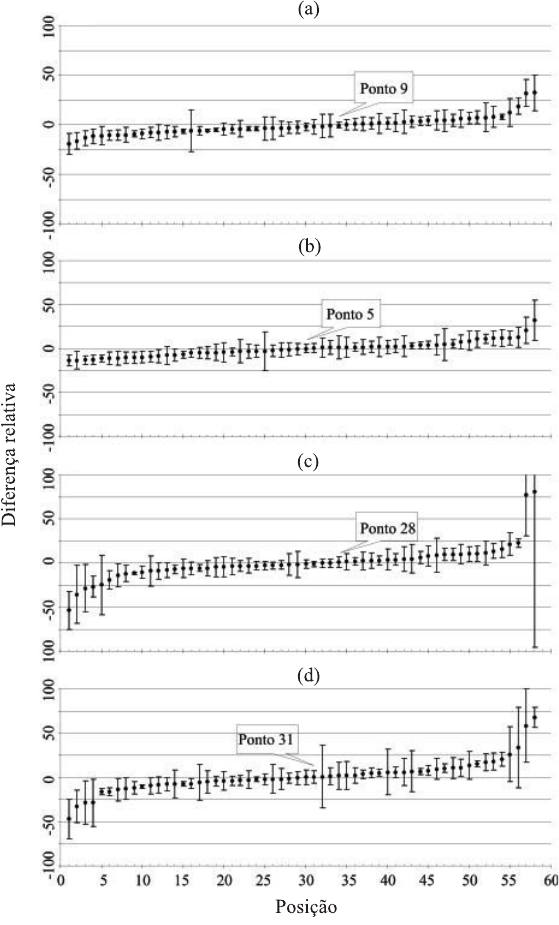
Figura 4. Diferenças relativas médias e respectivos desvios-padrão da umidade do solo (%) nas estações de inverno (a), primavera (b), verão (c) e outono